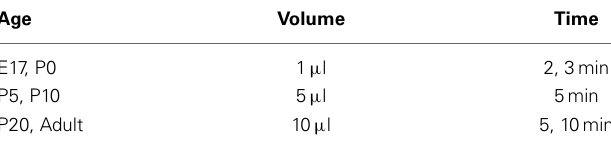
Table 1 | Volumes and times of injected probes at different